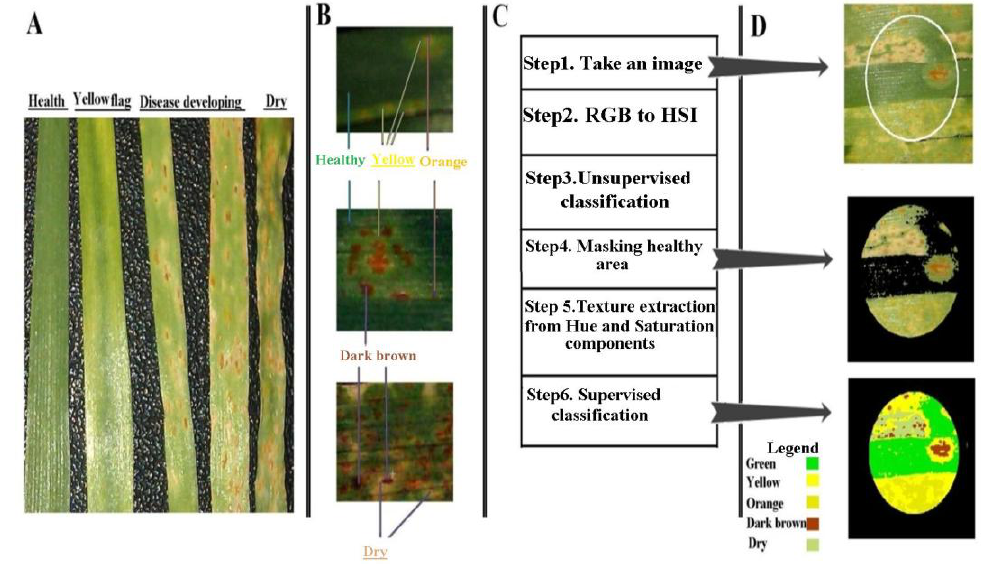
Figure 2. ( A ) Disease progress of wheat leaf rust; ( B ) Different symptoms of wheat leaf rust; ( C ) Classification steps of disease symptoms of wheat leaf rust by RGB digital camera; ( D ) Classification of different symptoms and masking green area of wheat leaf rust, the leaf area (fleaves were placed next to each other) marked by the contact probe is shown by the white